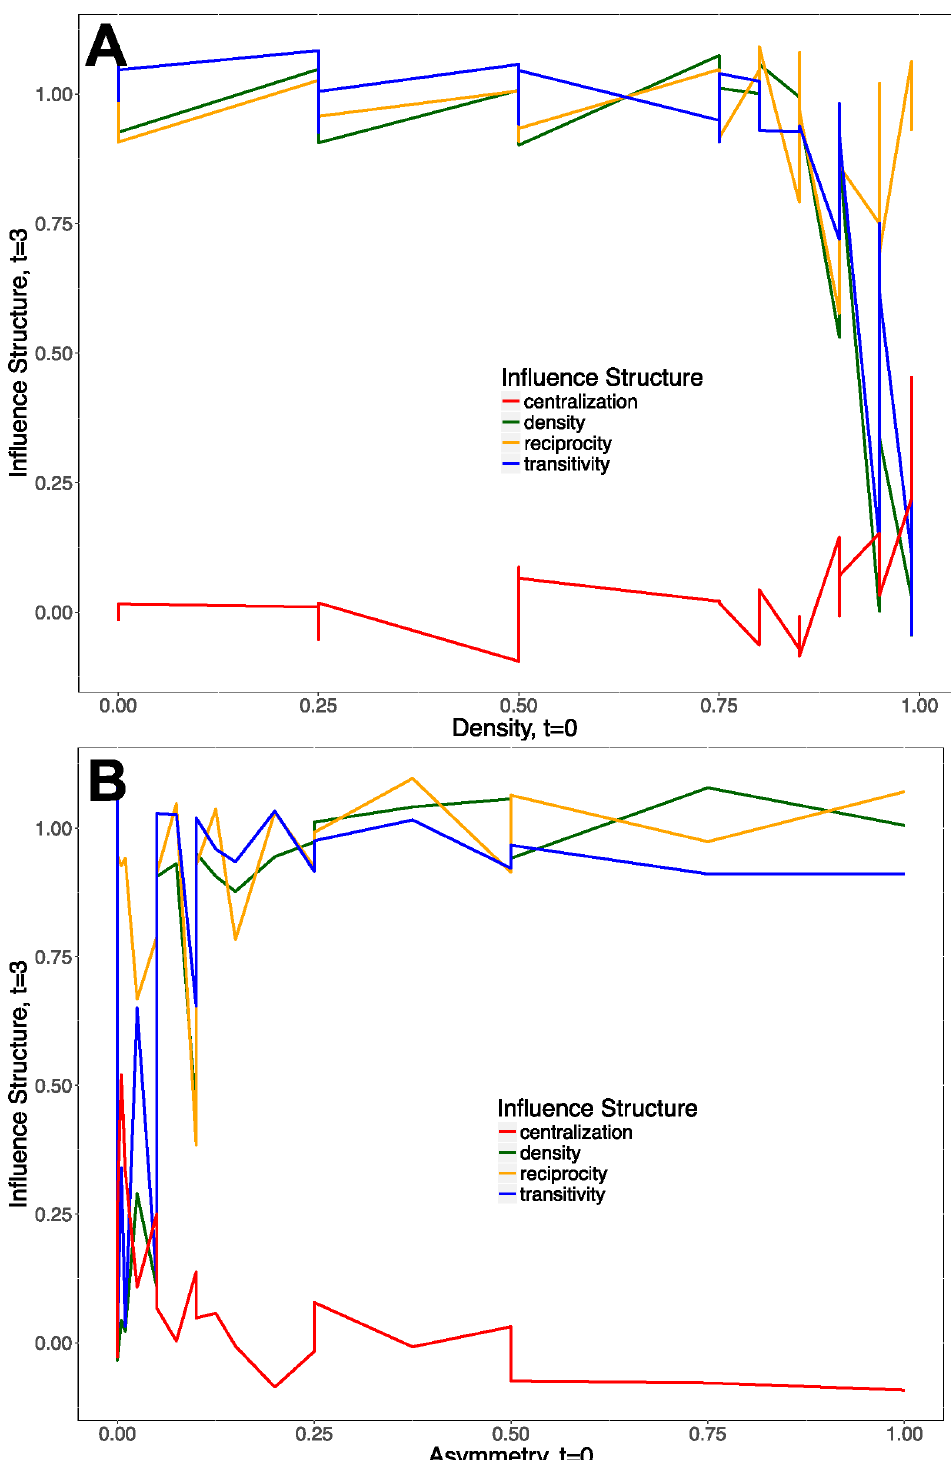
Fig 4. Evolution of social influence varying network density and asymmetry. A shows the relationship between initial graph density at t = 0 and graph properties at t = 3. B shows the relationship between initial graph asymmetry at t = 0 and graph properties at t =